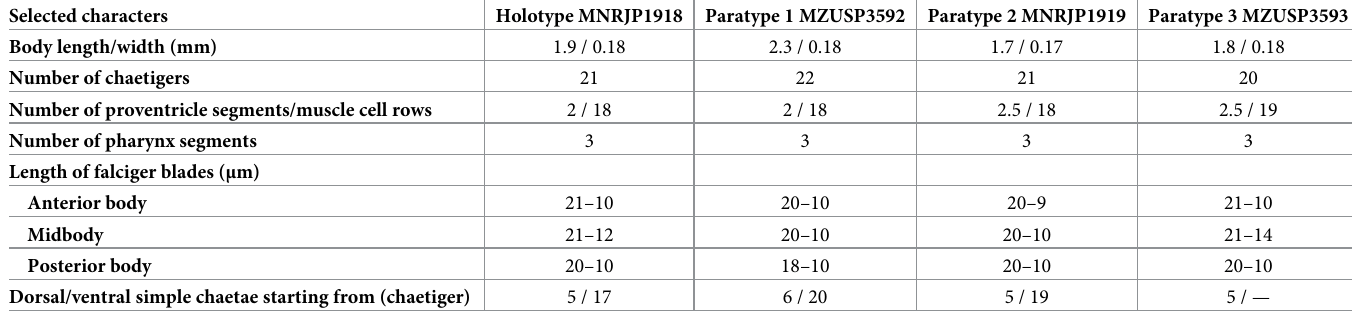
Table 2. Morphological variations of selected characters among specimens in the type series of Salvatoria marielleae n. sp. Selected